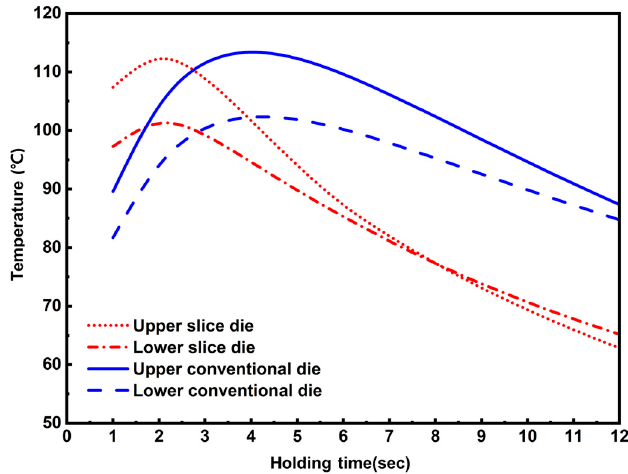
Figure 10. Temperature change at the contacted area with the blank in the conventional and slice dies according to holding time.